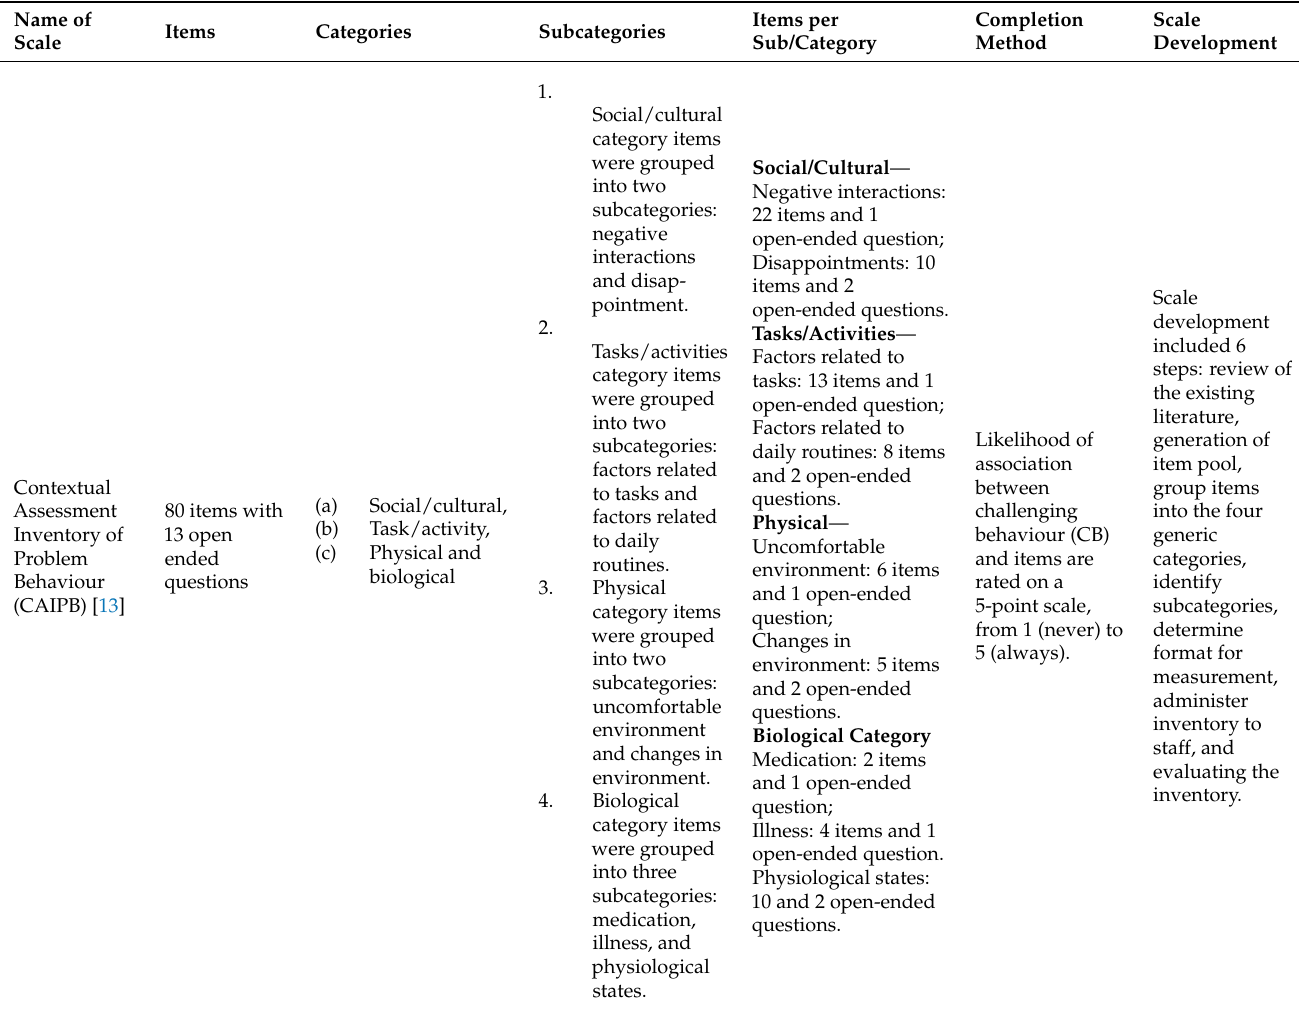
Table 2. Information on contextual/trigger